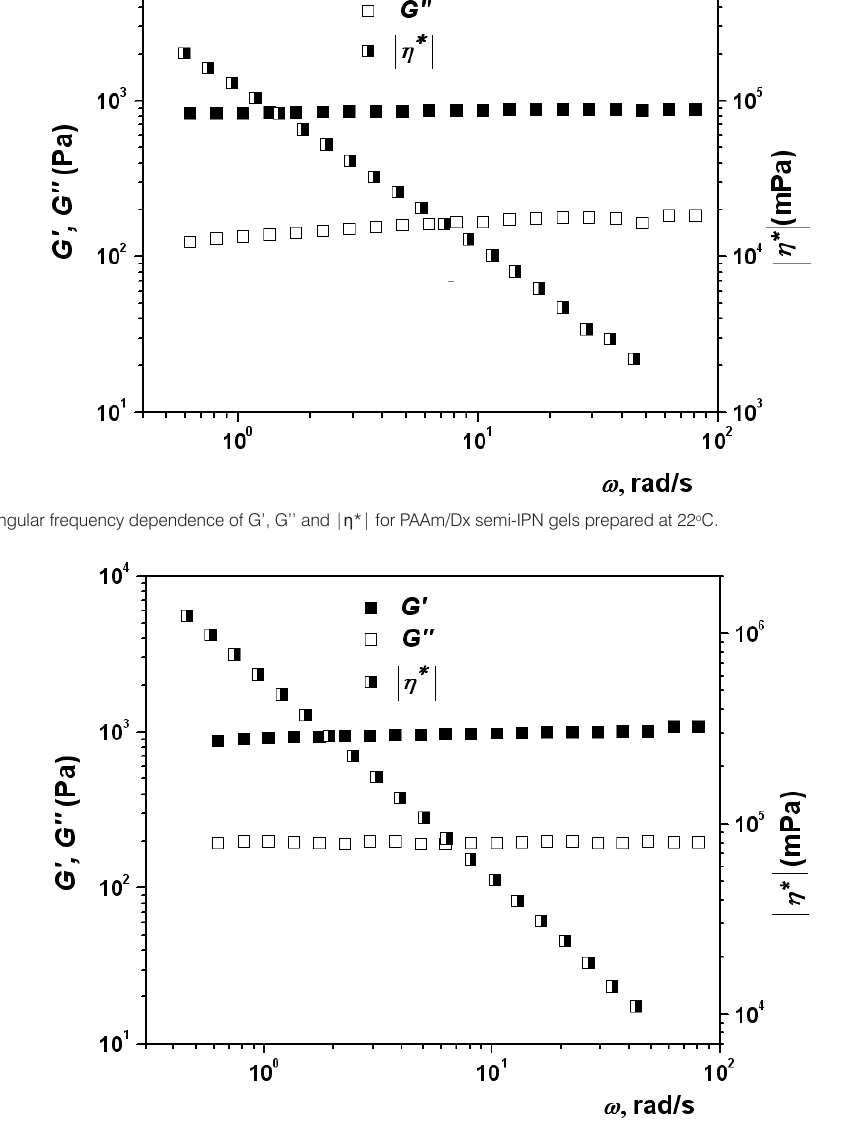
Figure 5. Angular frequency dependence of G’, G’’ and | η *| for PAAm/Dx semi-IPN gels prepared at 5 o